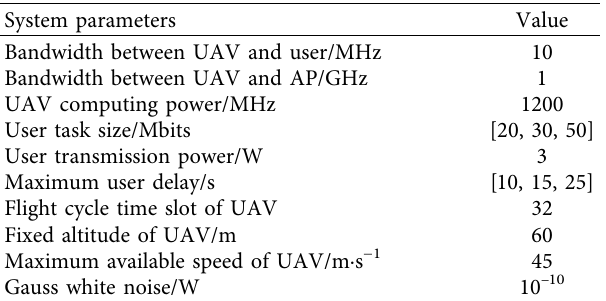
Table 1: System simulation